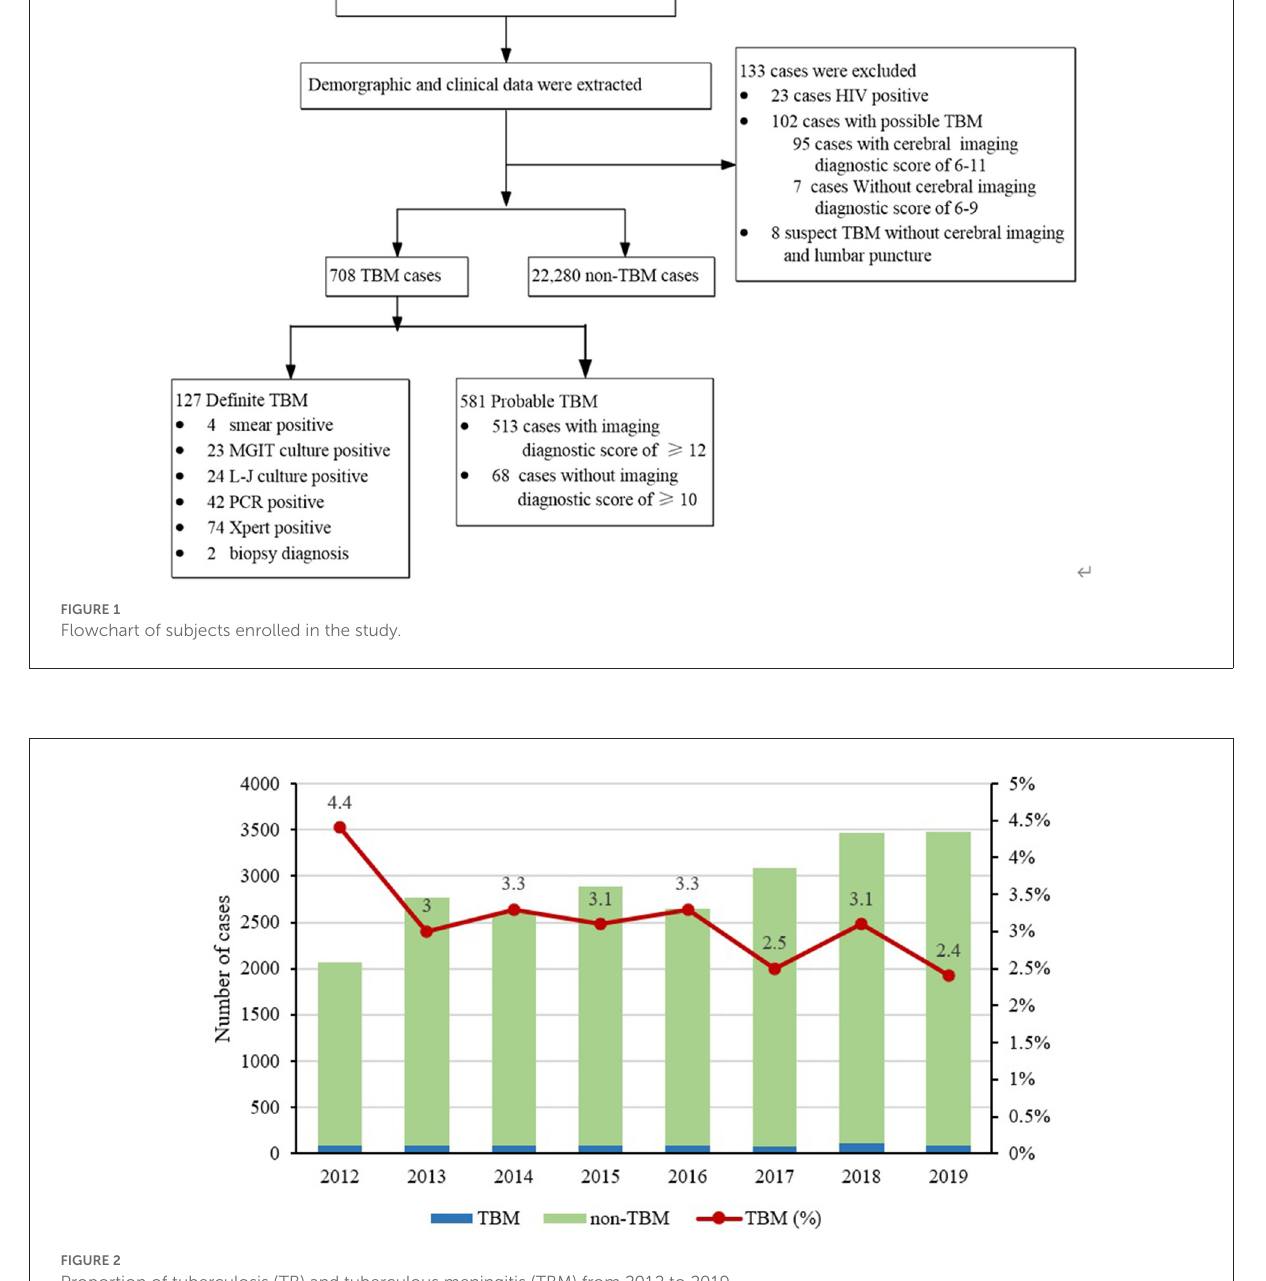
carcinoma, and malnutrition), and concurrent TB (miliary pulmonary TB, tuberculous pleuritis, lymph node TB, TB of the head and neck, digestive system TB, genitourinary TB, and vertebral TB) were significantly different among the three groups ( p < 0.05), as reported in Table